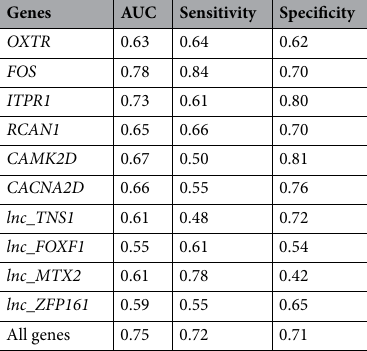
Table 4. Detailed characteristics of ROC curves.